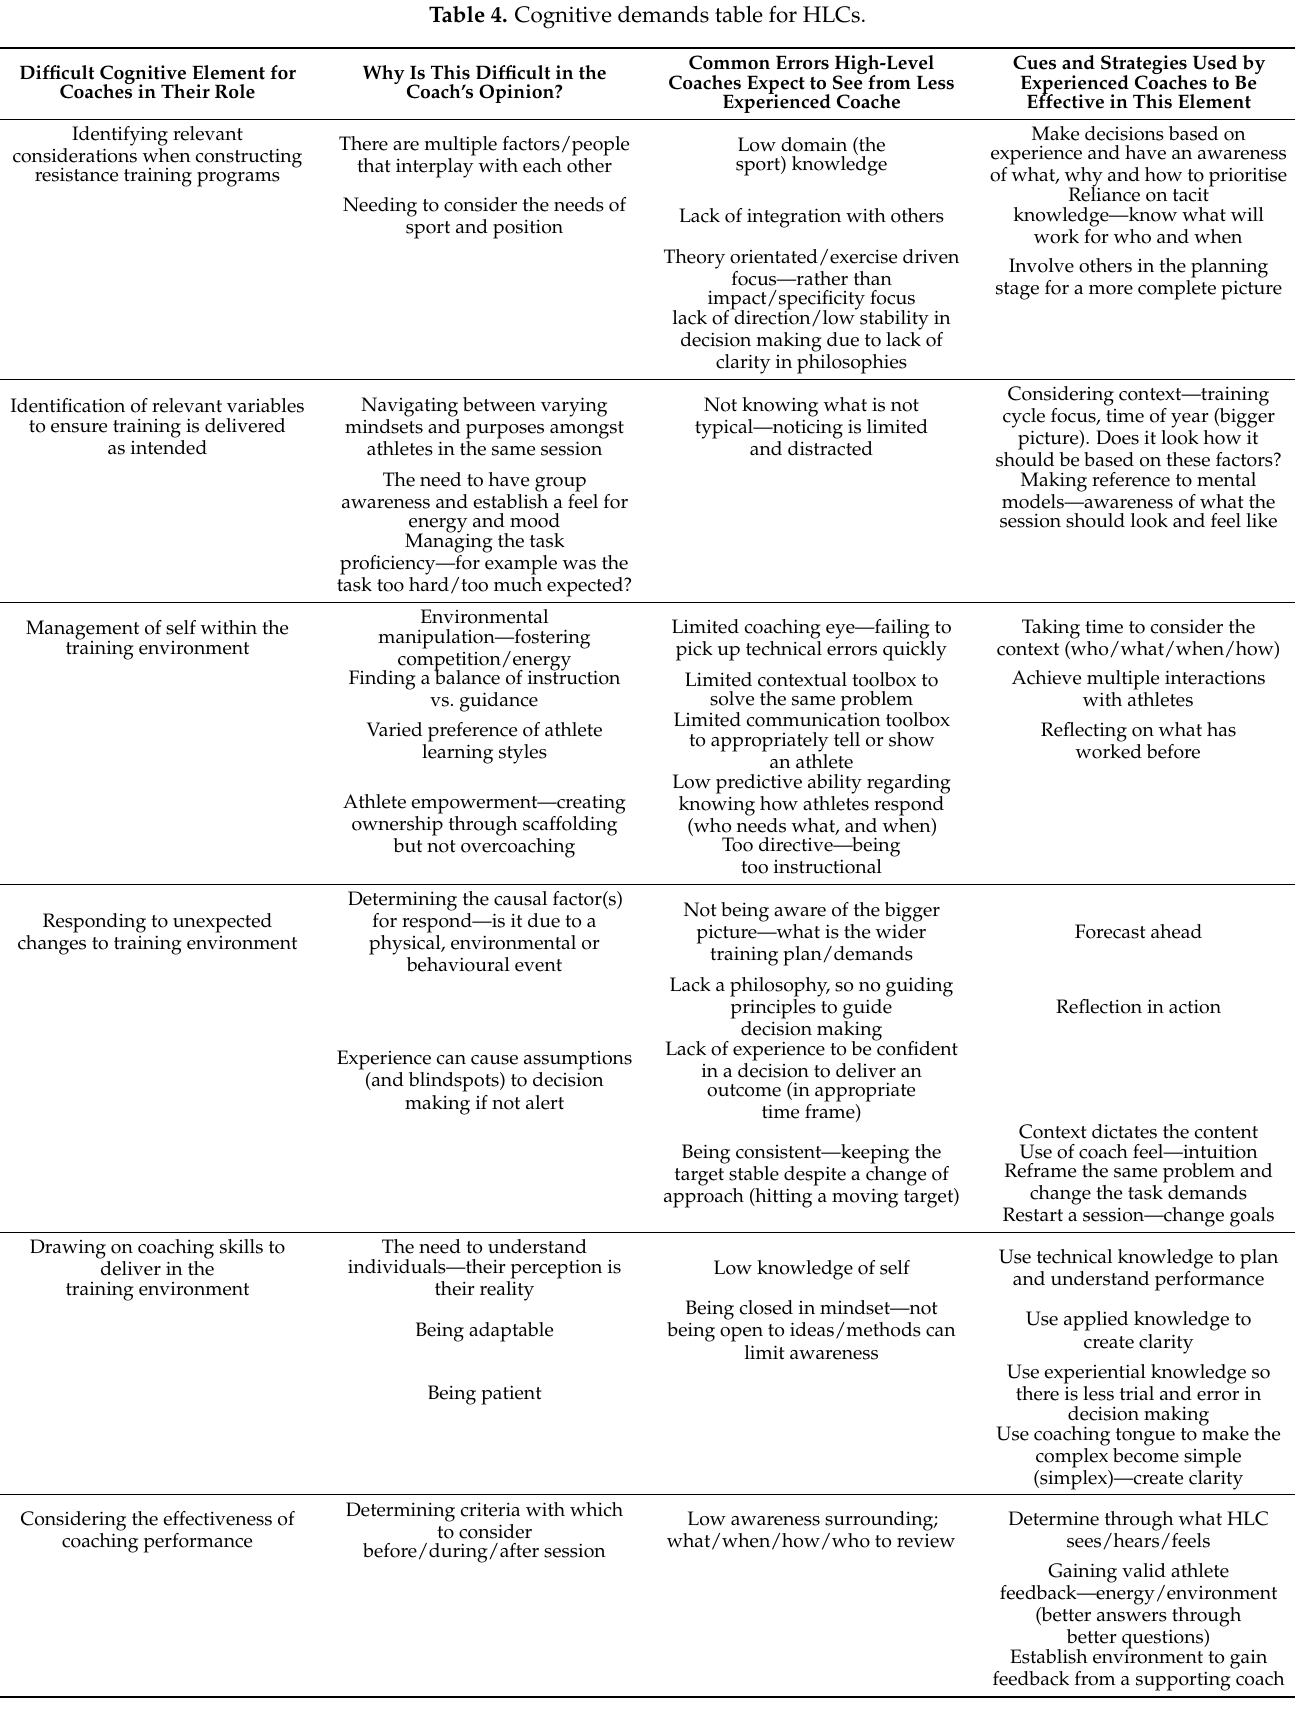
Table 4. Cognitive demands table for